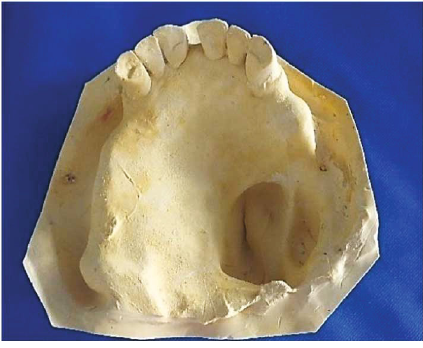
Figure 7: Maxillary